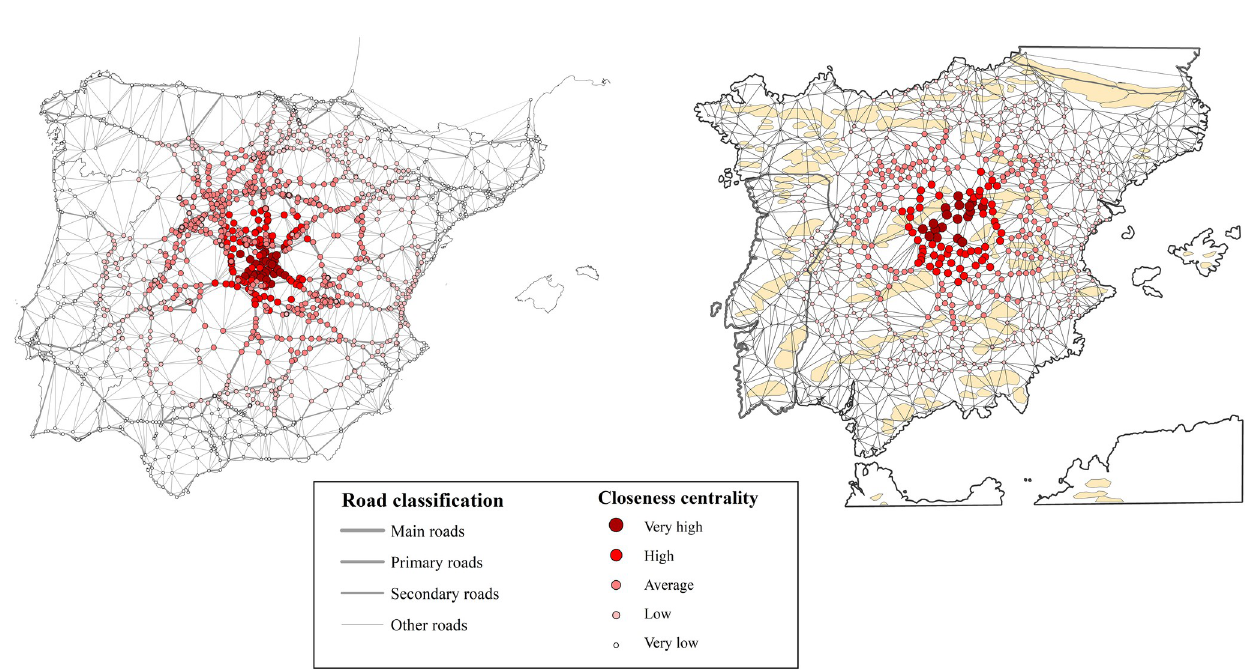
Fig 13. Closeness centrality maps. Notes: The calculation of closeness centrality does not take into account road categories because they refer more to aspects of traffic than to technical characteristics of roads. The length of the sections and their slope were included.